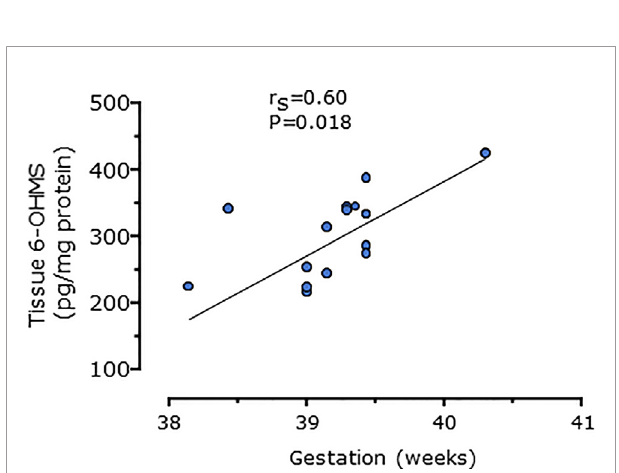
FIGURE 6 | Relationship between placental 6-hydroxymelatonin sulfate levels after elective C-section and gestational age in weeks (n = 15, P = 0.016, Spearman ’ s test), from MEL-P2.